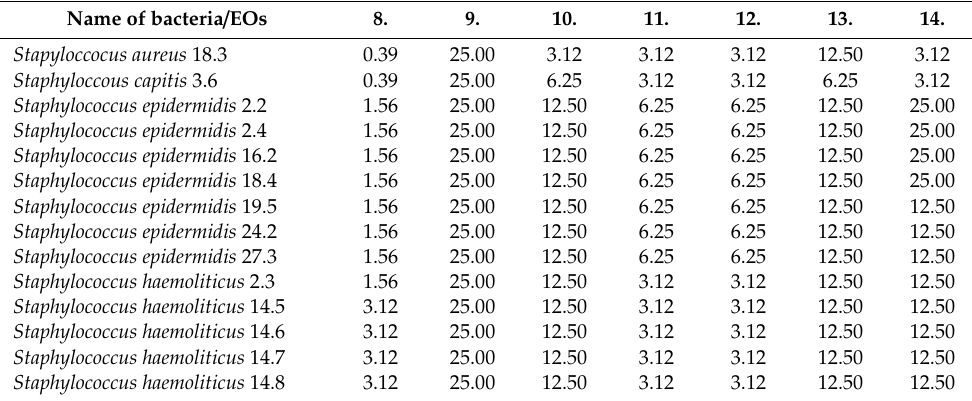
Table 6. Minimal inhibitory concentration of EOs in µ L /